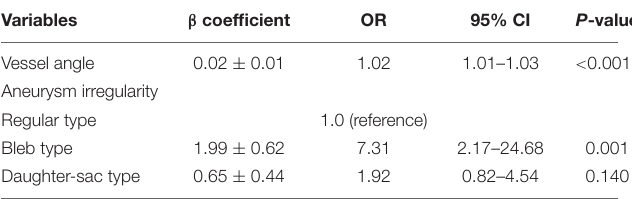
TABLE 3 | Results of multivariate logistic regression